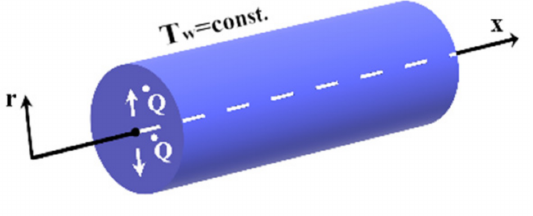
Figure 1. The cylindrical coordinate system used for numerical